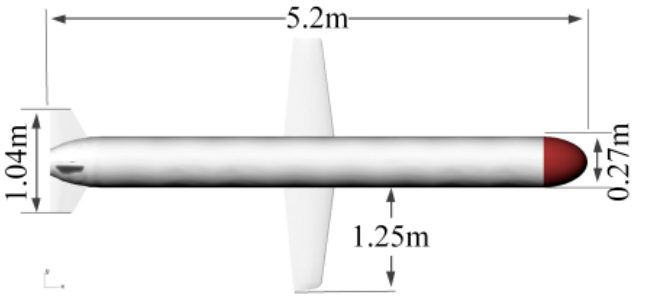
Figure 7. Geometry structure of the hybrid dielectric and conductor missile-like target.